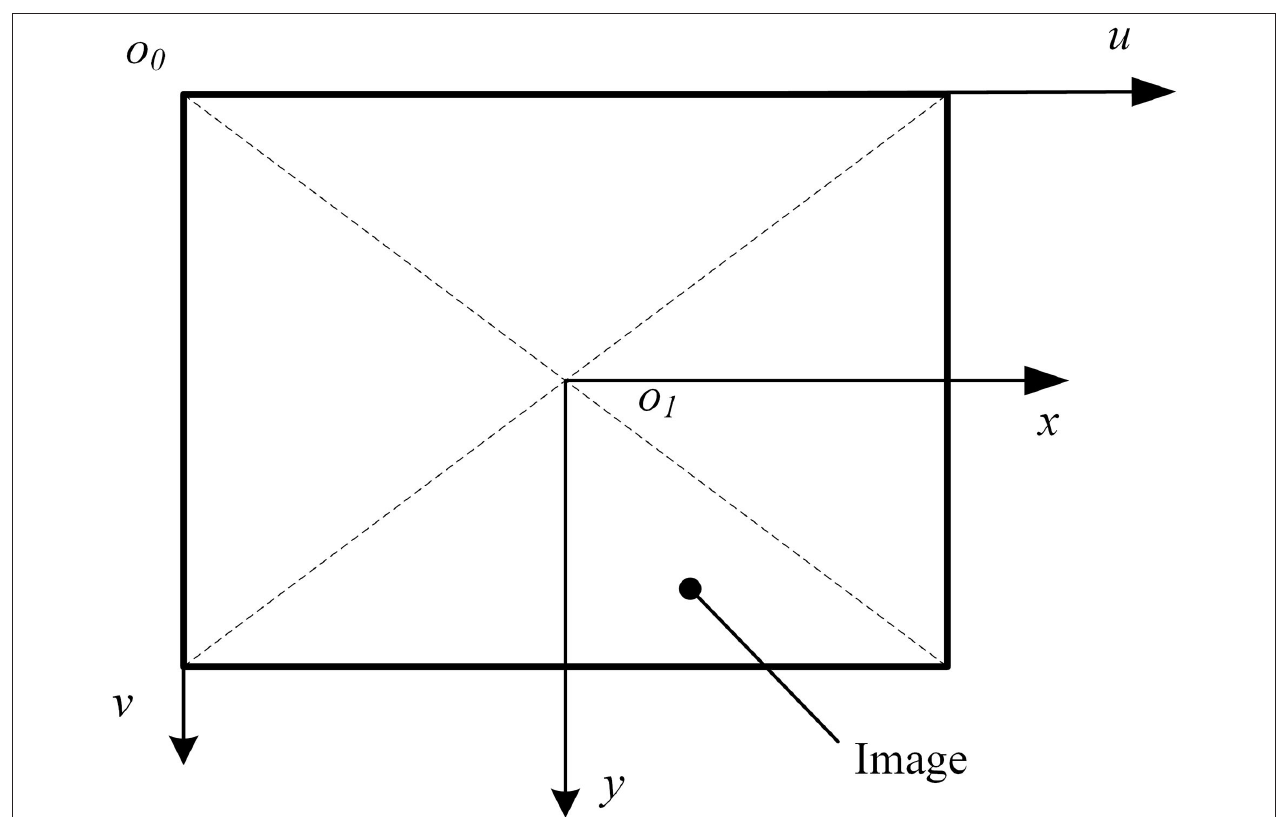
FIGURE 2 | Image pixel coordinate system and image physical coordinate